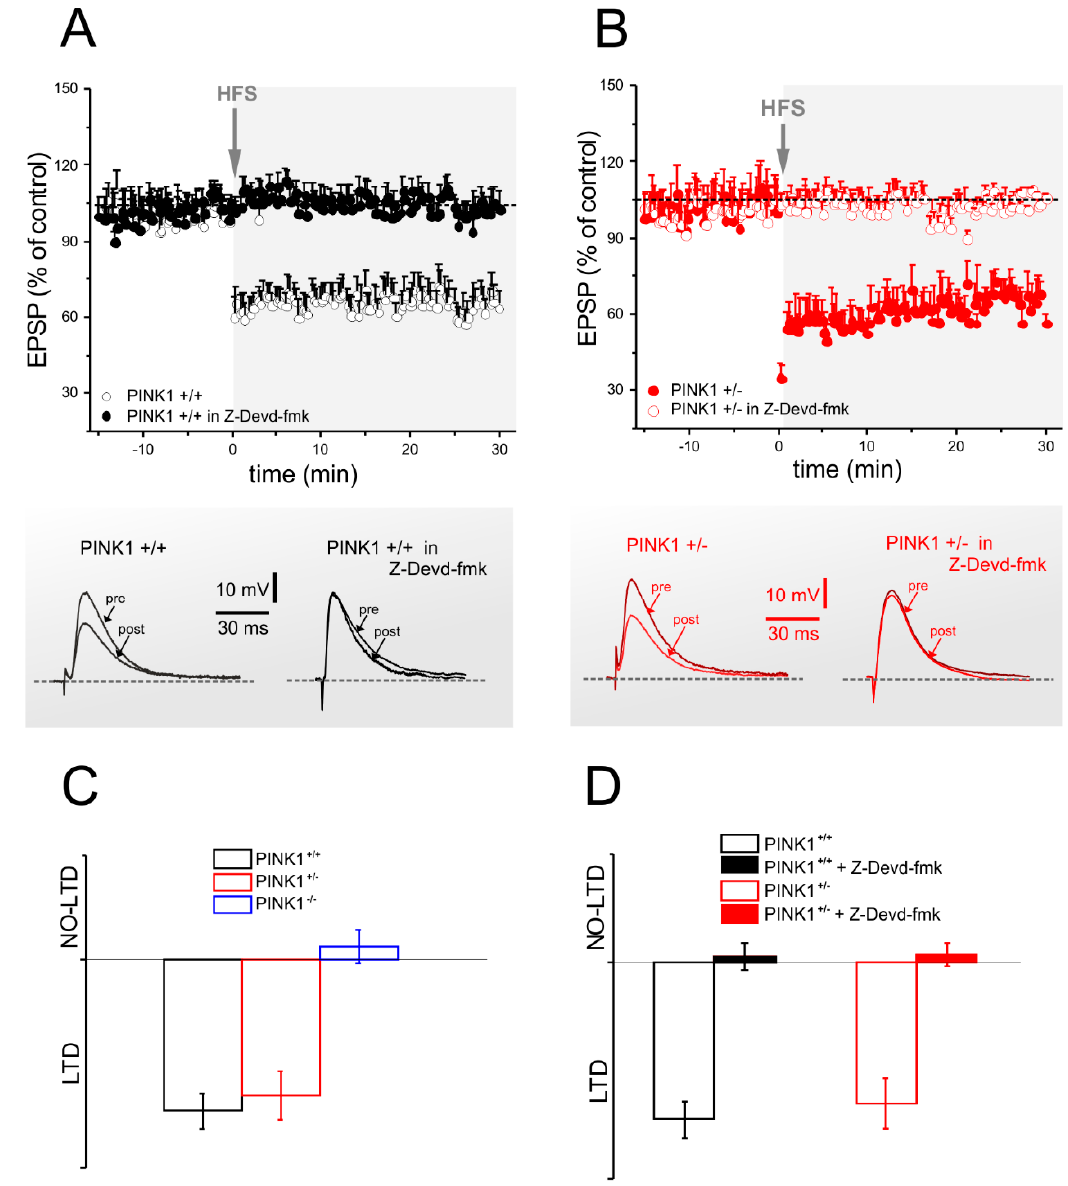
Figure 3. Long-term depression (LTD) in PINK1 +/+ and PINK1 +/ − mice is suppressed by caspase-3 inhibition. ( A , B ) Top. Time-course of LTD in PINK1 +/+ and PINK1 +/ − mice. Stimulus intensity was raised to reach threshold level for high-frequency stimulation (HFS). The amplitude of EPSPs was plotted over-time as percentage of the pre-HFS control EPSP. ( A ) HFS of corticostriatal glutamatergic a ff erents elicited a robust LTD in MSNs recorded from PINK1 +/+ mice (black dots), but not after pretreatment with the caspase-3 inhibitor Z-Dved-fmk (5 µ M) (white dots) (PINK1 +/+ in Z-Devd-fmk: 98.25% ± 2.12% of control, n = 8; Student’s t -test p > 0.05; PINK1 +/+ in saline: 63.70% ± 3.09% of control, n = 6; Student’s t -test p < 0.05). ( B ) Similarly, Z-Dved-fmk treatment suppressed LTD expression in PINK1 +/ − mice (PINK1 +/ − in Z-Devd-fmk: 105.69% ± 3.0% of control, n = 8, Student’s t -test p > 0.05; PINK1 +/ − in saline: 61.44% ± 1.28% of control, n = 10; Student’s t -test p < 0.05). Each data point represents the mean ± SEM of eight independent observations for each group. Bottom. Sample traces of representative EPSPs recorded before (pre) and 30 min after (post) HFS in PINK1 +/+ and PINK1 +/ − mice, both in control condition and after treatment with Z-Dved-fmk. ( C ) Plot summarizing corticostriatal LTD expression in PINK1 mice. ( D ) The plot summarizes the loss of corticostriatal LTD after Z-Dved-fmk treatment in PINK1 +/+ and PINK1 +/ − genotypes.